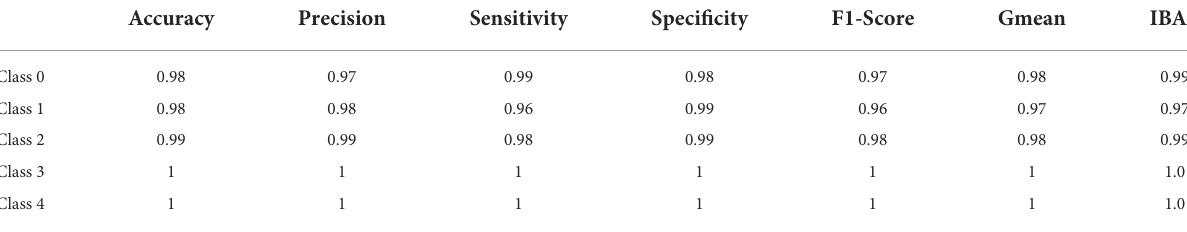
TABLE 8 Performance metrics of decision tree classifier with random over-sampling technique.